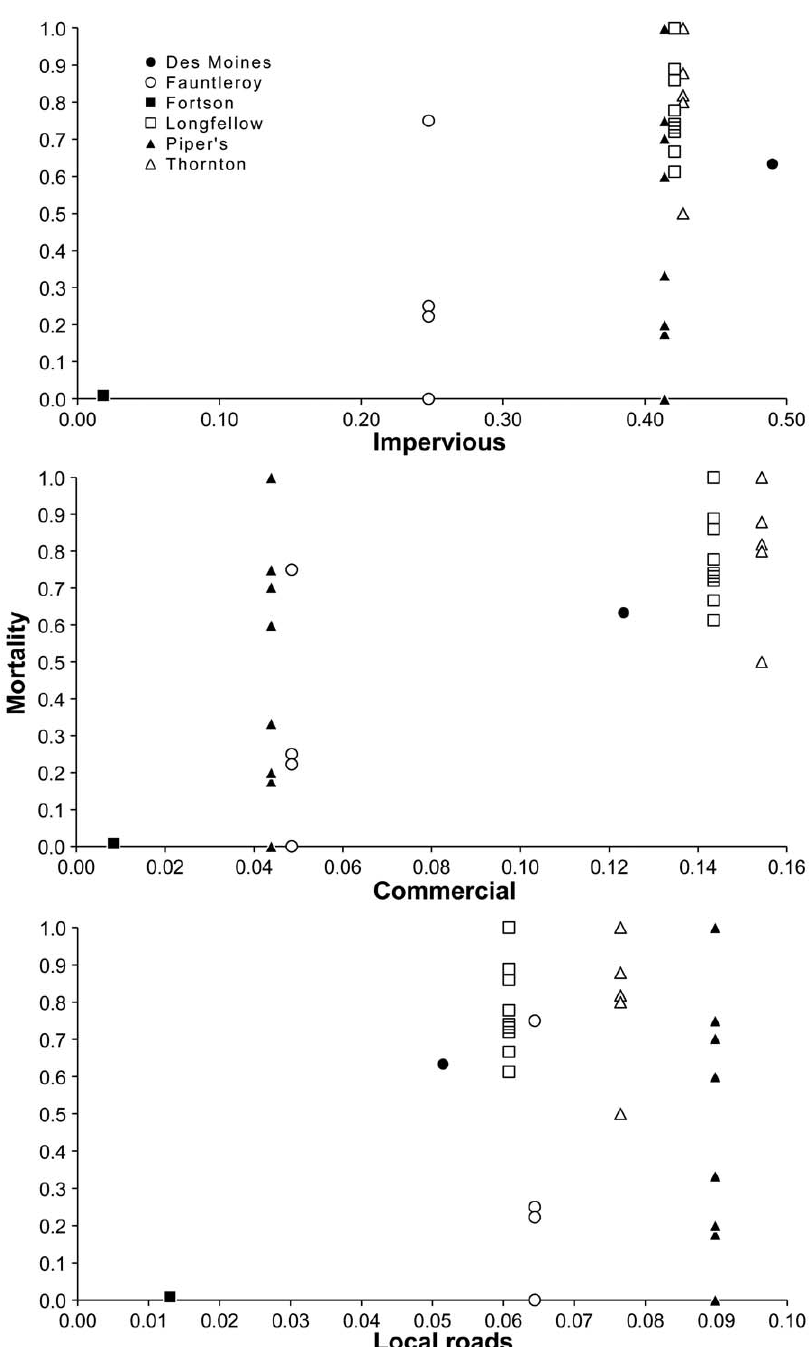
Figure 2. Female coho spawner mortality as a function of the proportion of each of the top three predictors in a given site basin, at the six study sites. Individual points correspond to specific years for each site. Mortality expressed as proportion of all returning females that died in a given year. Solid circle=Des Moines; hollow circle=Fauntleroy; solid square=Fortson; hollow square=Longfellow; solid triangle=Piper’s; hollow triangle=Thornton Creek. doi:10.1371/journal.pone.0023424.g002 teams have not observed the characteristic symptoms (e.g., housing aquaria that contained individual juvenile coho from the surface swimming, gaping) among other fish species that inhabit NWFSC hatchery. The juveniles (n = 20) were maintained and observed daily throughout the fall spawner run. Overall juvenile urban streams such as sticklebacks and cutthroat trout. Not only are coho unusual in this respect, the phenomenon appears to be survival was 100%, and the juveniles behaved normally, even on restricted to the adult life stage. In the fall of 2003, surface flows days when symptomatic adults were observed in the nearby from Longfellow Creek were diverted through streamside sheds stream (Scholz et al., unpublished data). The underlying reasons